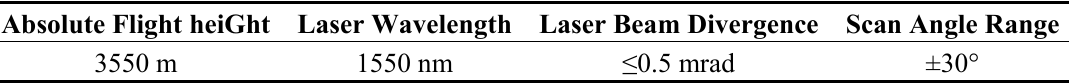
Table 1. LMS-Q560 flight and system